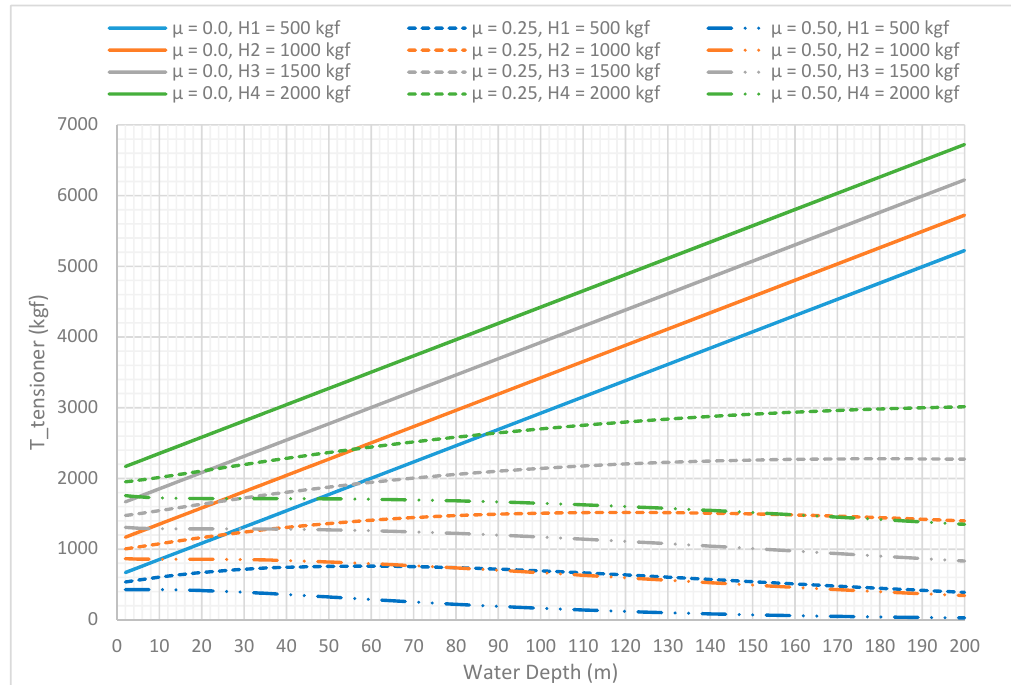
Figure 19. Cable tension variation at ship using different friction coefficients (0–0.50), water depths (2 m–200 m) and bottom tensions (500 kgf–2000 kgf).